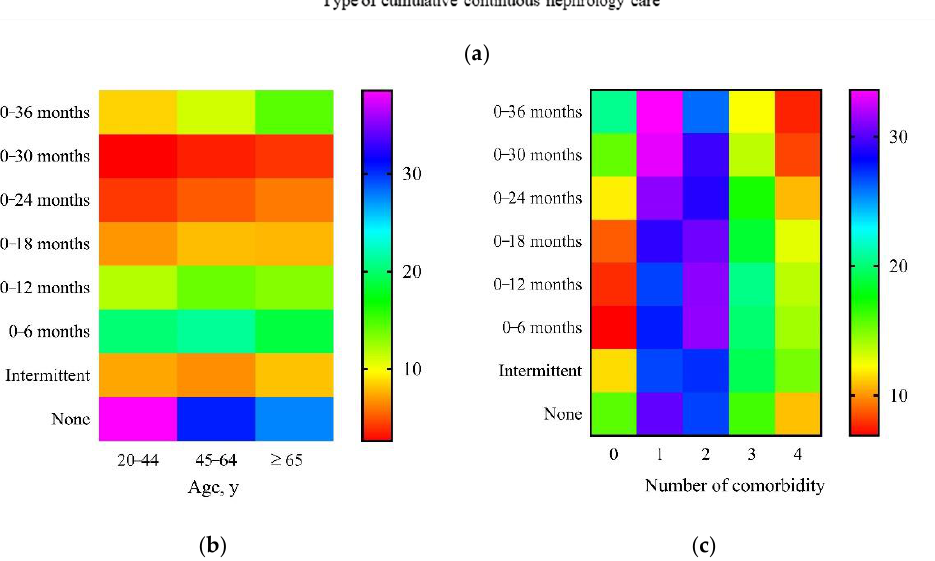
( b ) Figure 3. Cumulative mortality proportion between ( a ) ≥1 year vs. <1 year nephrology care; ( b ) types of cumulative neph- rology care. The time was calculated from the date of dialysis initiation to the date of death, or the end date of the first year, whichever came first. Cumulative one-year mortality proportions were estimated by the Kaplan Meier approach and assessed the differences between groups by Gehan – Breslow – Wilcoxon test.p<0.001